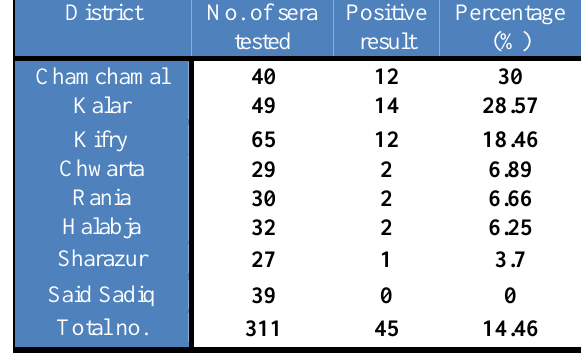
Table, 1: Positivity of sheep and goat brucellosis by using mRBT according to districts.